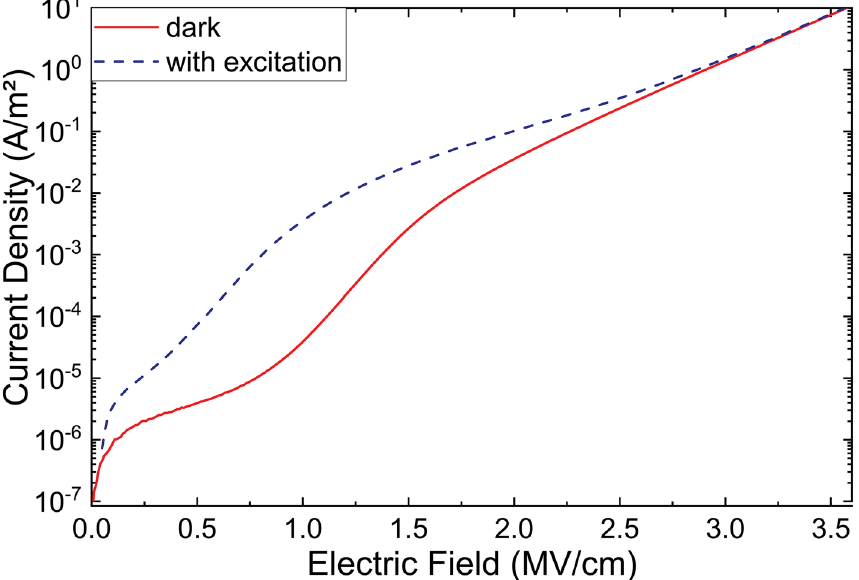
Figure 1. Field–current density plots for a NC superlattice of 18 bilayers, prepared without additional blocking oxide